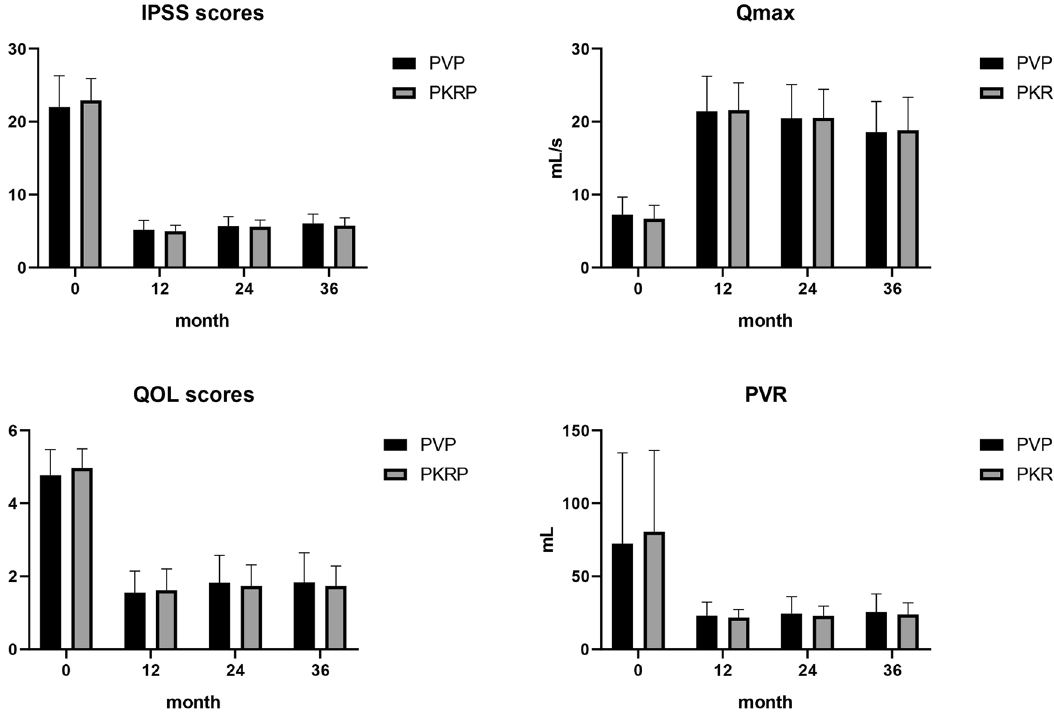
Figure 2. IPSS, QoL score, Qmax, and PVR during the 12-month, 24-month, and 36-month follow-up. (P < 0.05) (‘0’ represents preoperative).